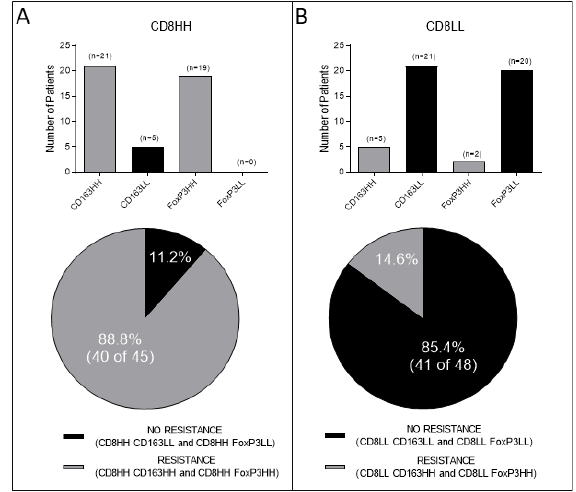
Figure 2. Association between CD8+ and CD163+ or FoxP3+ cell densities jointly in the Tumor Center (TC) and in the Invasive Margin (IM). ( A ) Number of patients with high CD8+ densities in the TC and IM (CD8HH) and either high or low densities of CD163+ (CD163HH or CD163LL, respectively) or high or low densities of FoxP3+ (FoxP3HH or FoxP3LL, respectively) cells. ( B ) Number of patients with low CD8+ (CD8LL) densities and either high or low densities of CD163+ or FoxP3+ cells in the TC and IM.